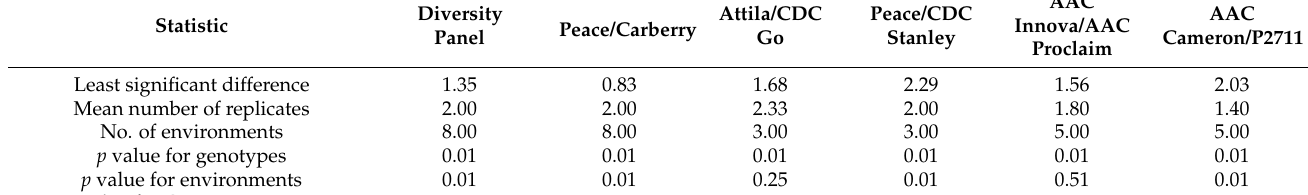
Figure 1. Comparison of reaction to stripe rust recorded in six spring wheat populations evaluated across all three to eight field environments (overall) and each environment. The individual environ ‐ ment starts with a prefix representing location (Cres: Creston, Leth: Lethbridge, Edm: Edmonton, Ell: Ellerslie), followed by the year of the trial. Table 1. Summary statistics of variance component analyses and broad ‐ sense heritability of stripe rust in six spring wheat populations evaluated at three to eight field environments.